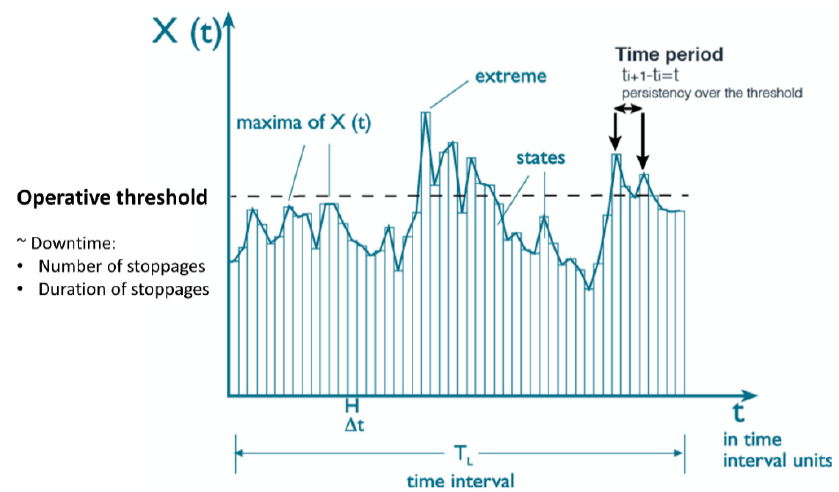
Figure 7. Exceedance of an operational threshold for a variable X within the framework of climate states. Every single bar represents the ergodic and stationary interval of a climate state ( ∆ t). Adapted from ROM 0.0 (2001) [1].